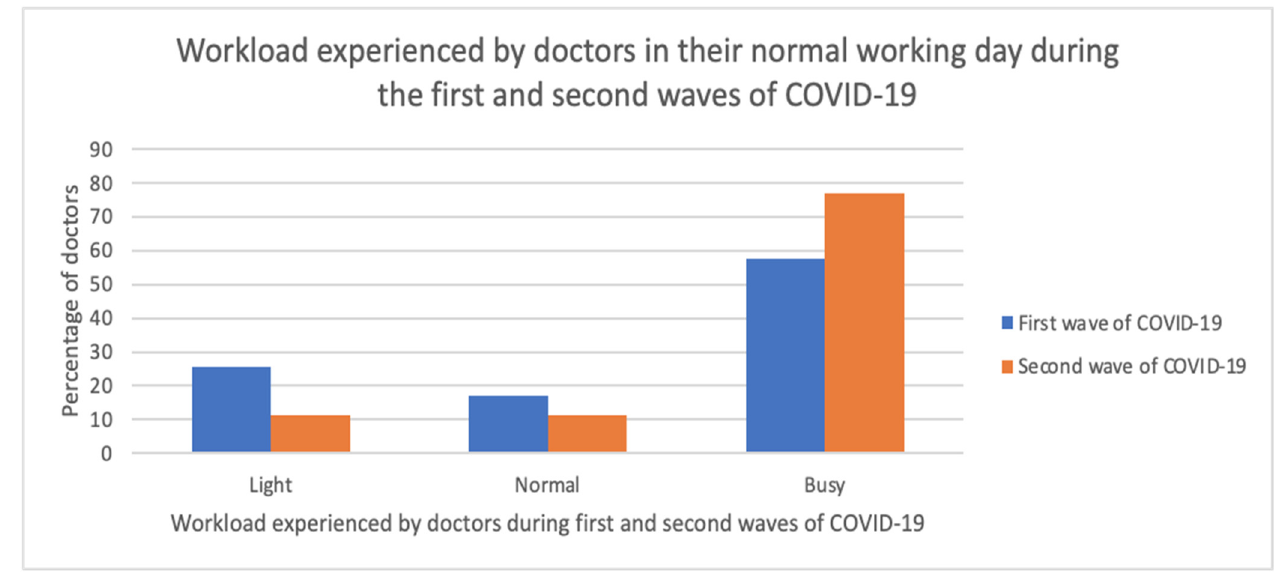
Figure 1. Workload experienced by doctors in their normal working day during the first and second waves of COVID-19.